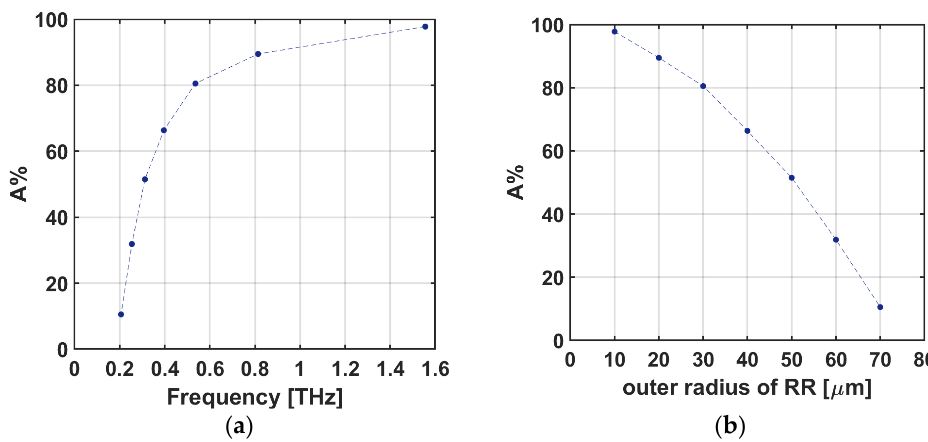
Figure 9. The absorption percentage of unit cell G vs ( a ) frequency, and ( b ) radius of the RR antennas. 323